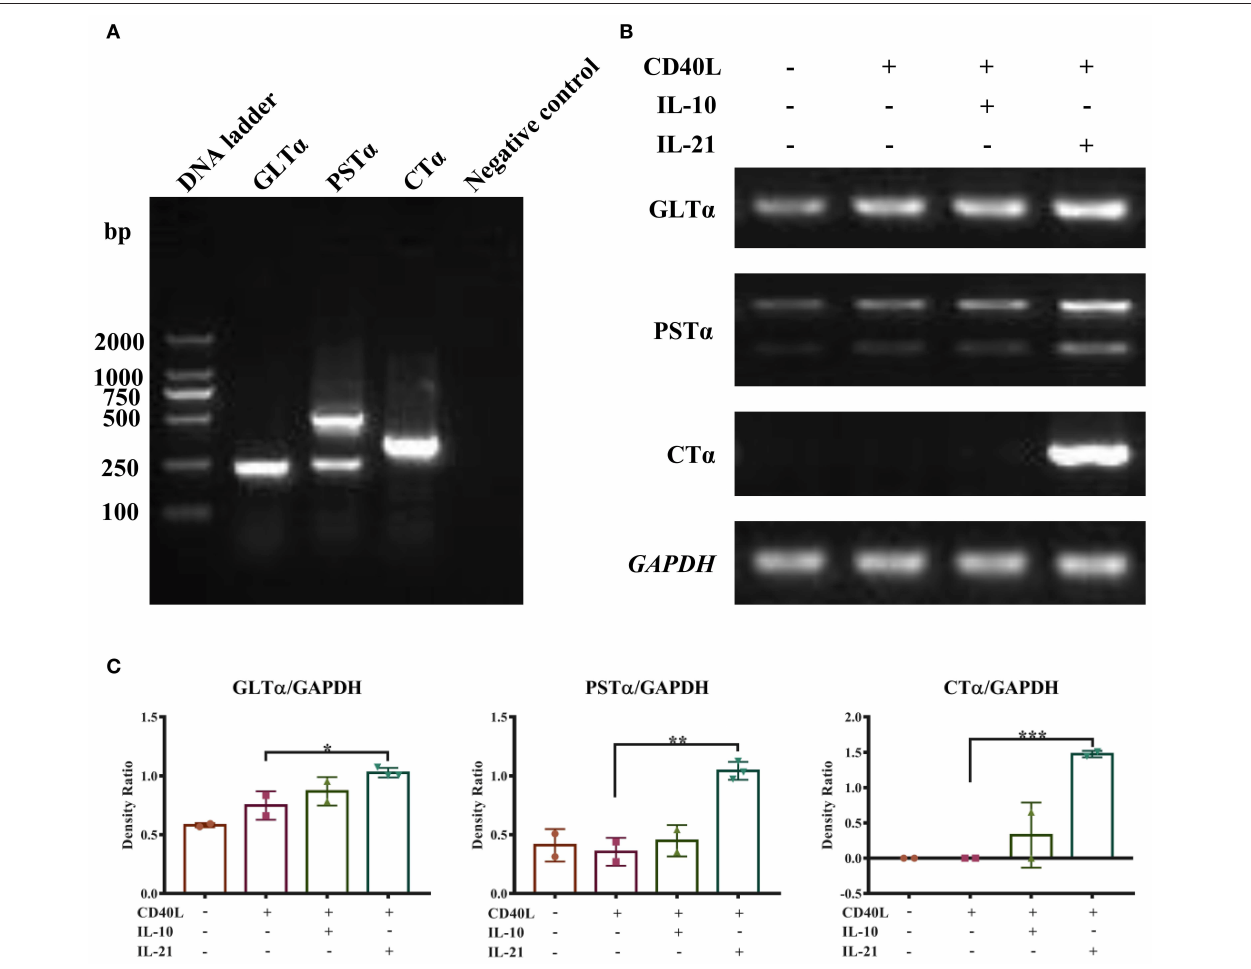
FIGURE 3 | IL-21 induces IgA CSR in IgM + B cells. Semi-quantitative RT-PCR methods were developed to detect the molecular markers for IgA CSR, and representative PCR products of GLT α , PST α , and CT α are shown (A) . IgM + B cells were cultured alone or together with CD40L/IL-10/IL-21 for 72h, and RNA was extracted. Semi-quantitative RT-PCR was performed to analyze the expression of molecular markers for IgA CSR. Representative results of the expression of GLT α , PST α , CT α , and GAPDH (B) , and their density ratios normalized by GAPDH (C) . * p ≤ 0.05; ** p ≤ 0.01; *** p ≤